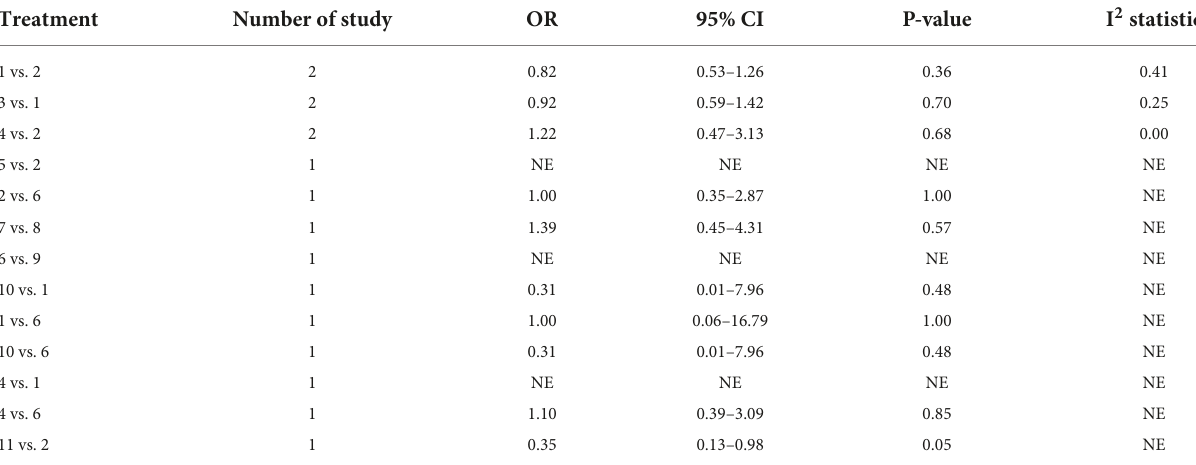
TABLE 6 The direct evidence from pairwise meta-analysis and heterogeneity of different anesthetics. Treatment Number of study OR 95% CI